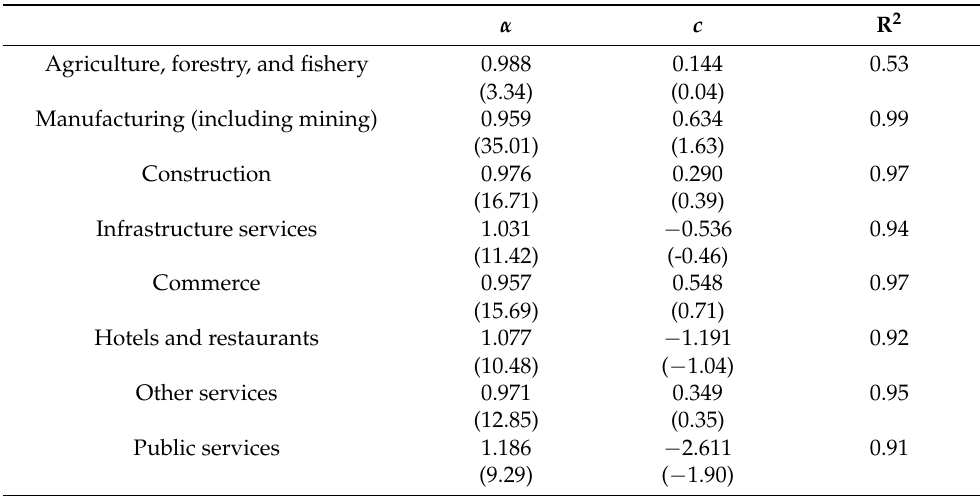
Table 7. Estimated parameters by I/O–spatial interaction